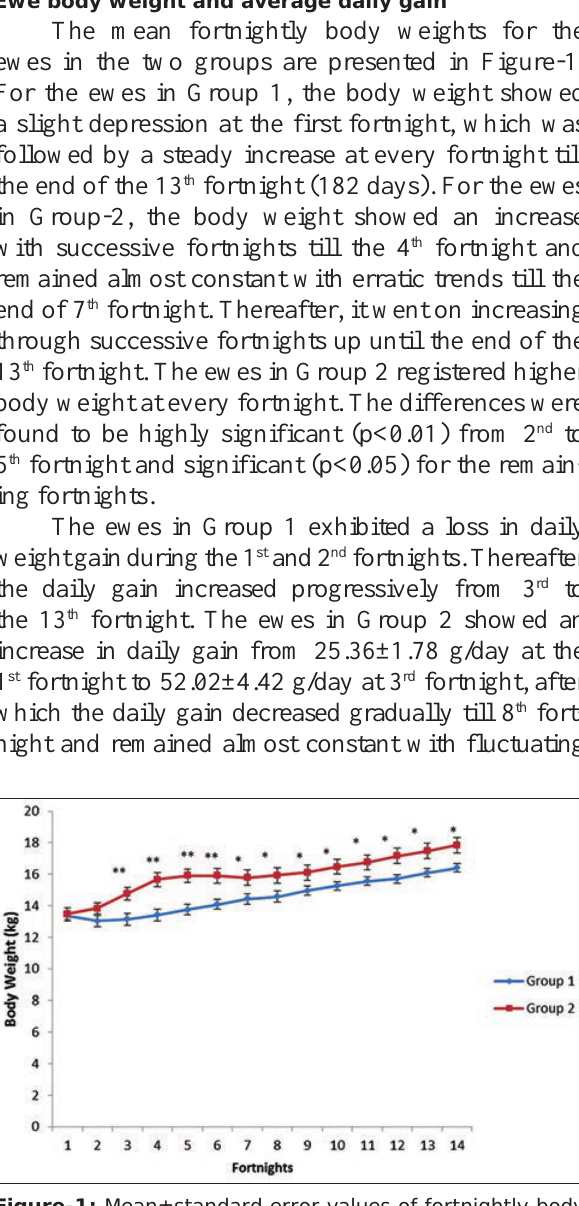
Figure-1: Mean±standard error values of fortnightly body weight of ewes of different groups. *Significantly different from the base value (p<0.05). **Significantly different from the base value